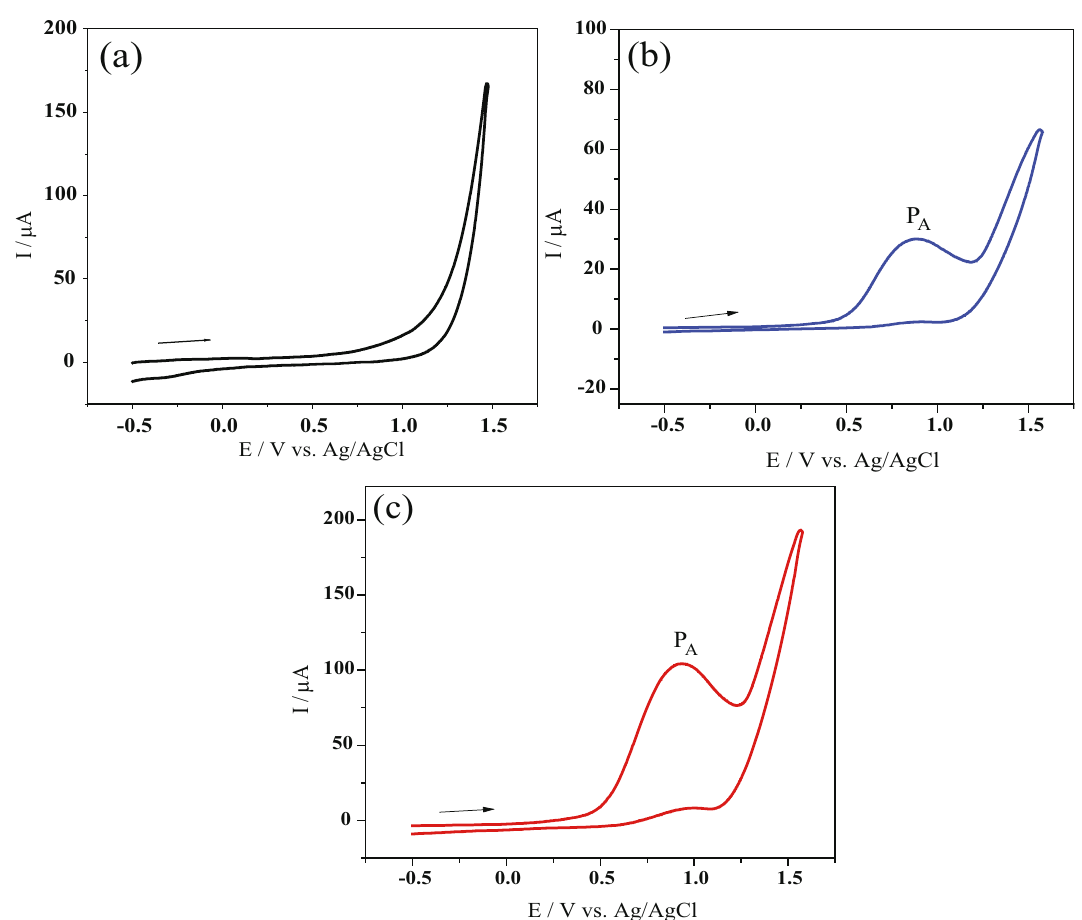
Figure 4: CVs of 0.5 mM NPX in 0.1 M PBS ( pH = 7.0 ) using a bare CPE ( a ) , the GQDs/CPE ( b ) , and the poly ( r - o - NBA ) /GQDs/CPE ( c ) at a scan rate of 100 mV · s − 1